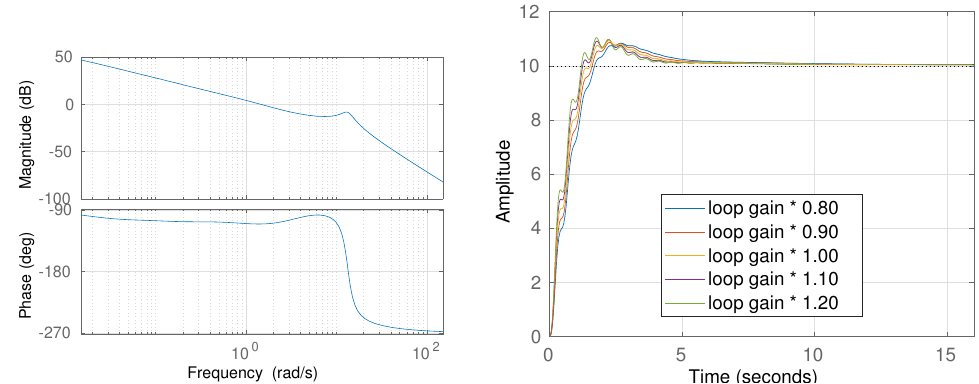
Figure 7. Frequency response ( left ) and time response ( right ) for the fractional order controller system.